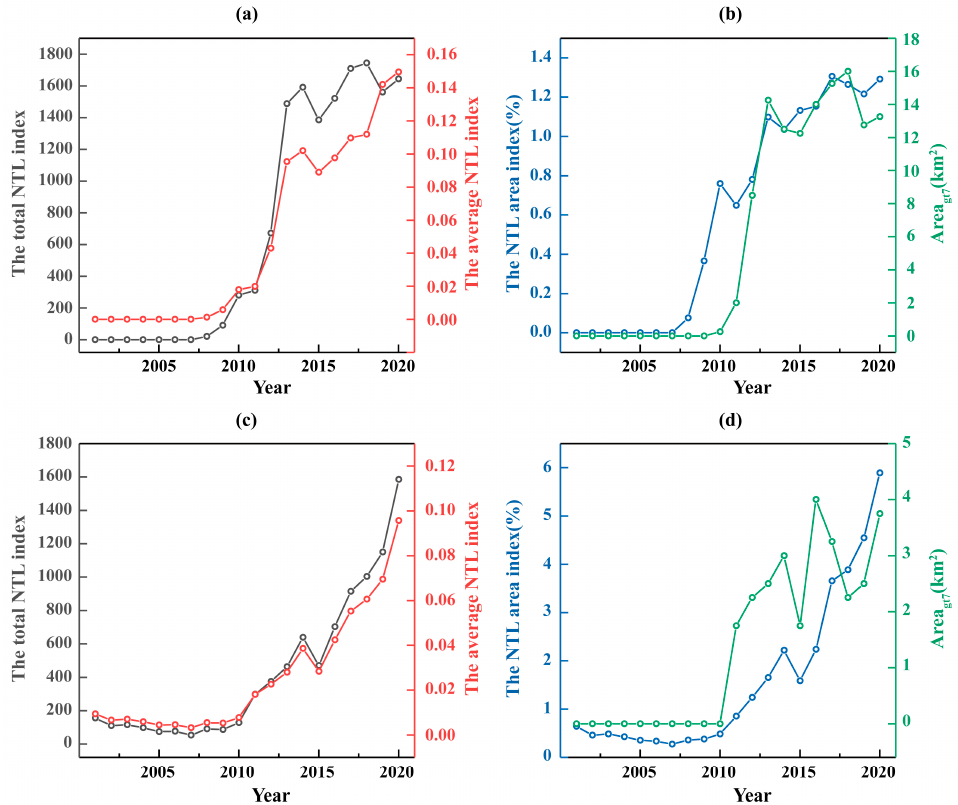
Figure 7. Trends of different NTL indices in the monitoring area from 2001 to 2020 ( a , b ) for Sino Iron and ( c , d ) for Taldybulak Levoberezhny.